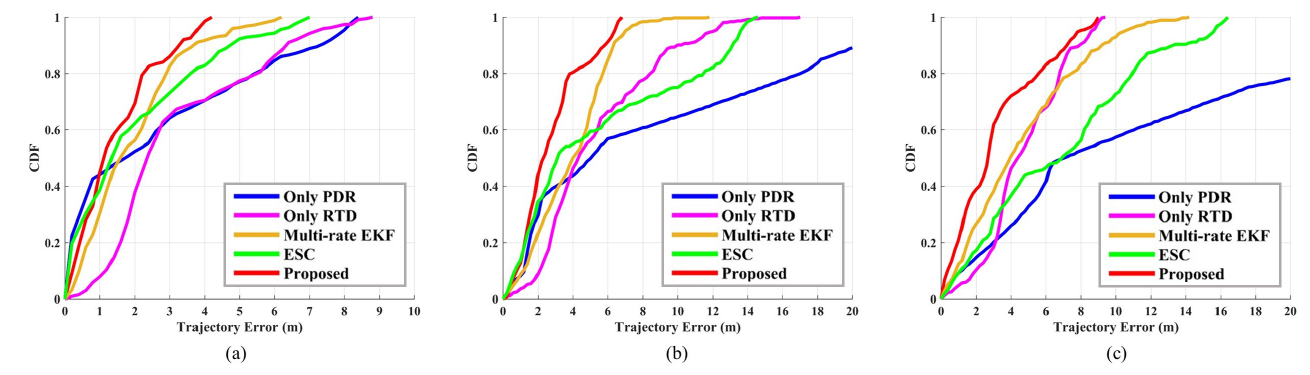
Figure 10. Cumulative distribution function of three-lap GNSS/PDR fusion test of five pedestrian